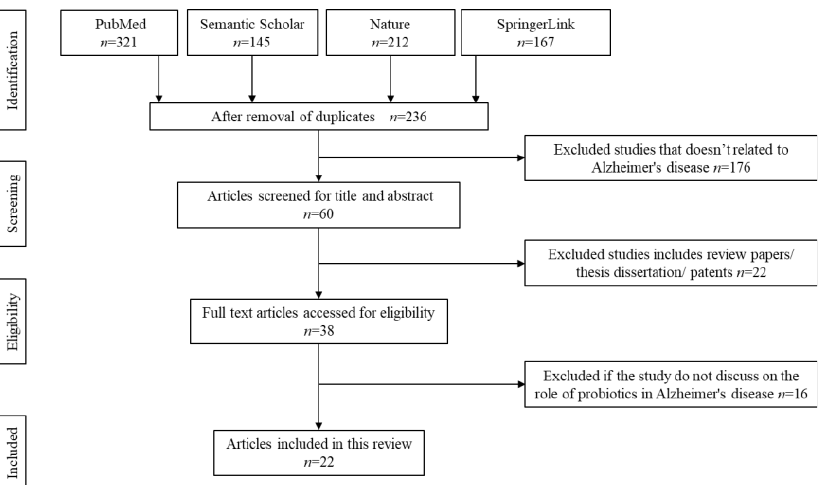
Figure 1. Identification and screening for literature search.